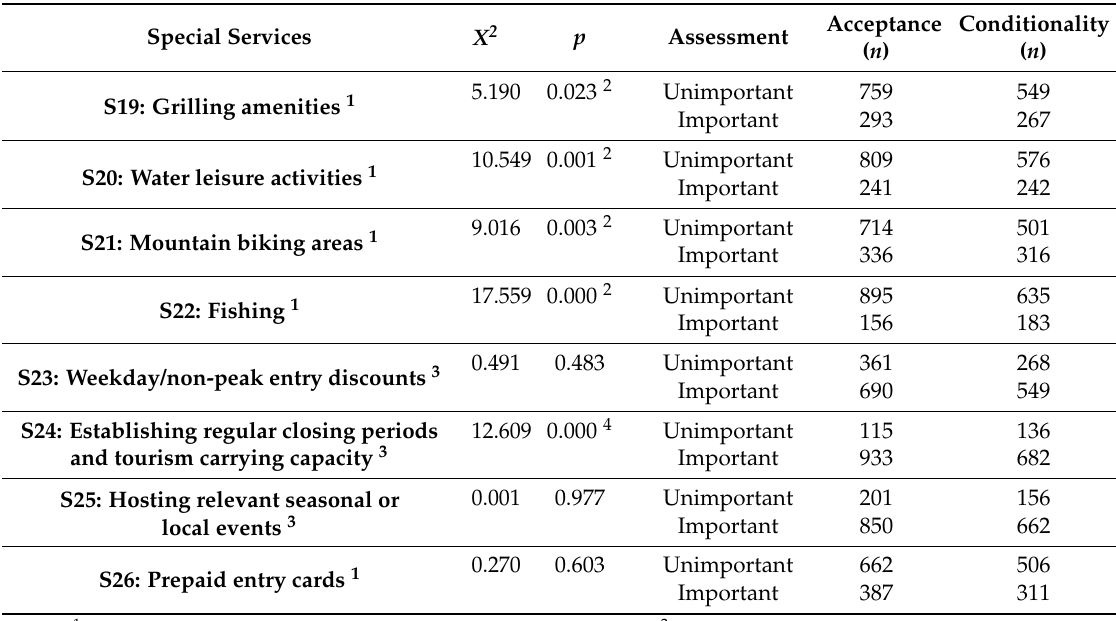
Table 6. Perceptions of the importance of special services by